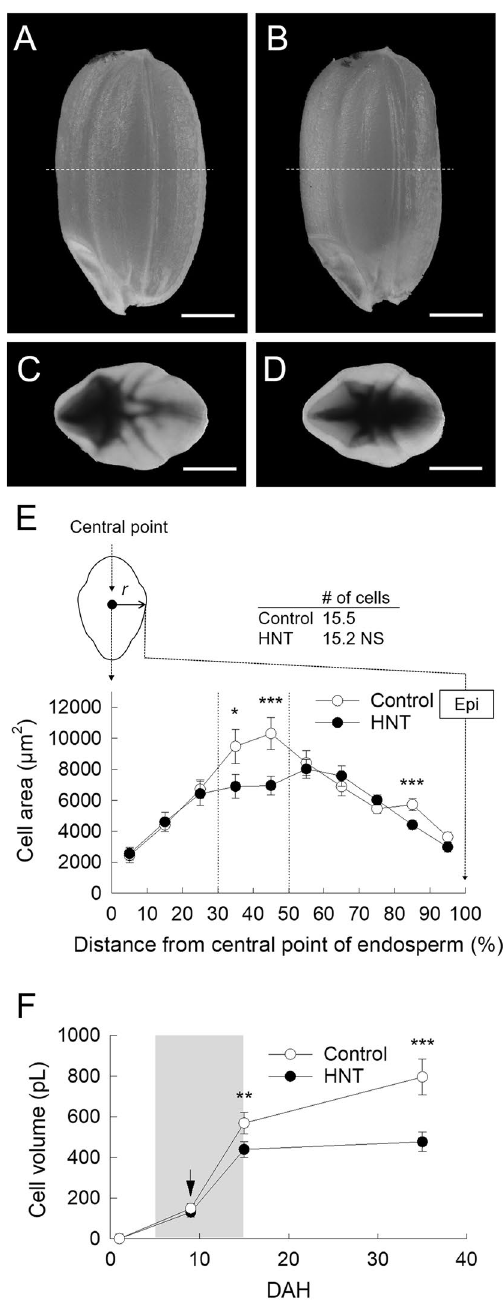
Figure 1. Images of mature rice kernels in control ( A , C ) and HNT treatment ( B, D ). ( C ) and ( D ) indicate the top view of the mature kernels. 35 DAH endosperm cell area plotted against the distance (in %) from central point to the lateral epidermis of transverse sections (corresponding to the dashed line in A and B ) of the kernels in each treatment ( E ). In the inset in ( E ), number of endosperm cells across the same zone was counted. Epi, epidermis; NS, no significance. Time course of changes in inner endosperm cell volume (corresponding to the dotted line in E , 30–50% distance) in each treatment ( F ). White and black circles in ( E ) and ( F ) indicate the control and HN treatments, respectively. The gray area in ( F ) indicates the duration of treatment; an arrow indicates the time conducting picoPPESI-MS and water status measurements. Data in ( E ) are the mean ± SE of 7–64 individual cells collected in 4–5 kernels from three plants. Data in ( F ) are the mean ± SE of 30–58 individual cells collected in 3–5 kernels from three plants.*, ** and *** shows p < 0.1, 0.05 and 0.01 by t- test, respectively. ( A – D ) scale bars = 1